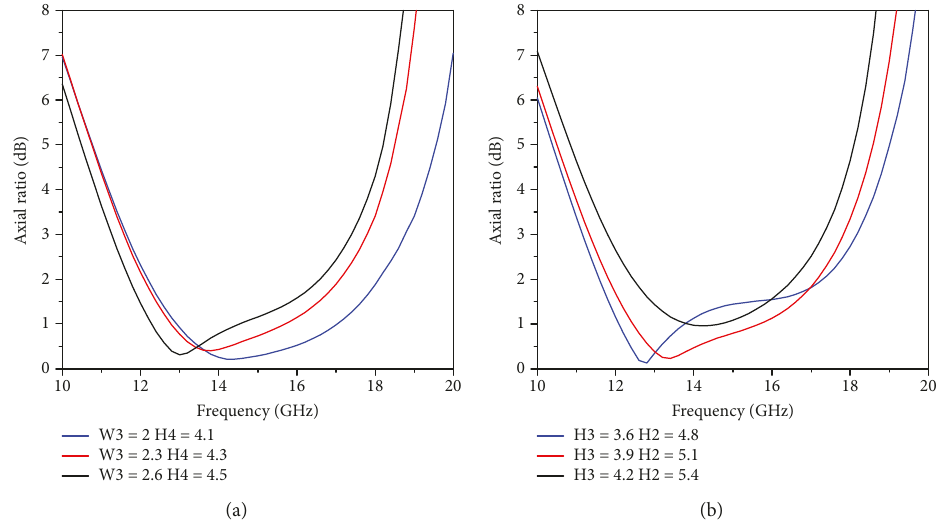
Figure 4: Simulated axial ratio of the proposed FSS for di ff erent (a) parameters of middle patch structure and (b) parameters of top and bottom grid